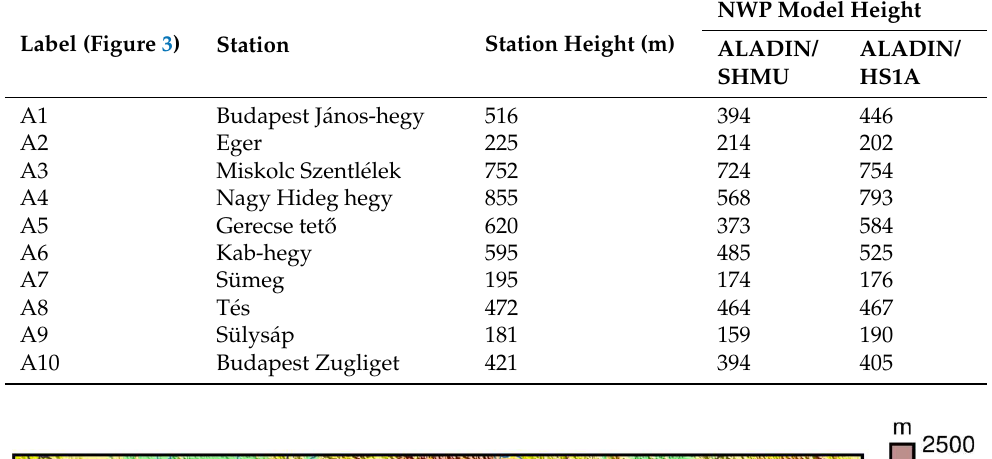
Table 2. List of AWS stations used for case studies and their a.s.l. height in meters. The A10 station (Budapest Zugliget) is not depicted on maps due to its close proximity to Budapest János-hegy (1.3 km distance).